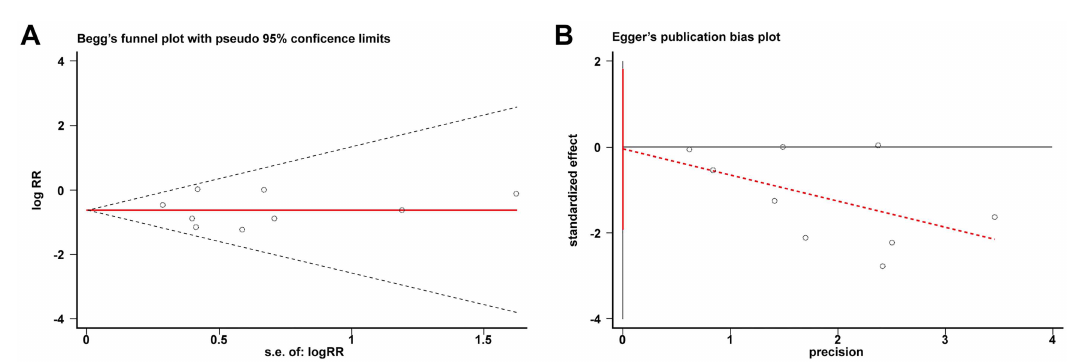
Fig 6. The Beg funnel plot (A) and the Egger funnel plot (B) tests showed no significant publication